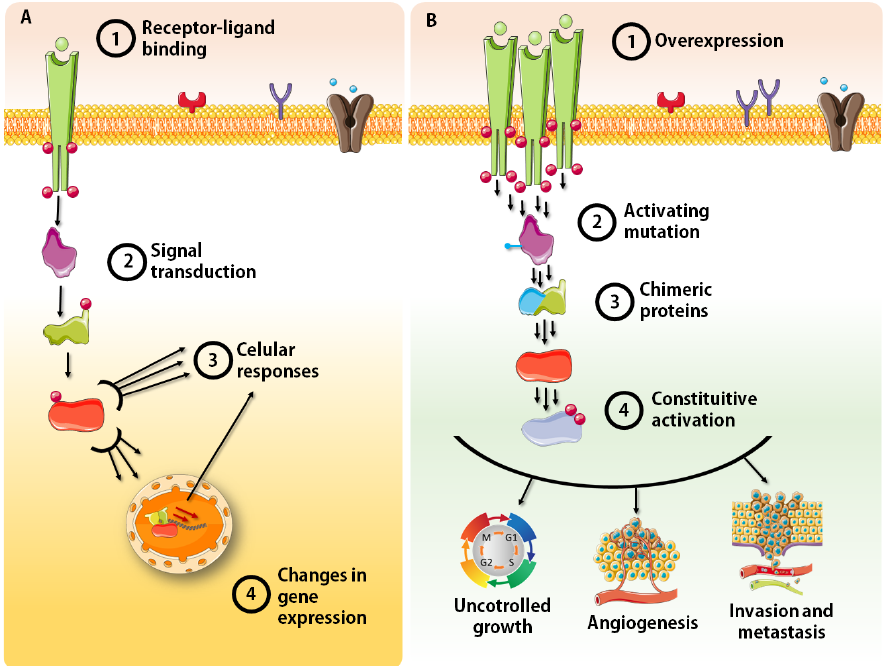
Figure 1. ( A ) Protein kinases may be triggered or deactivated in many ways, acting as key